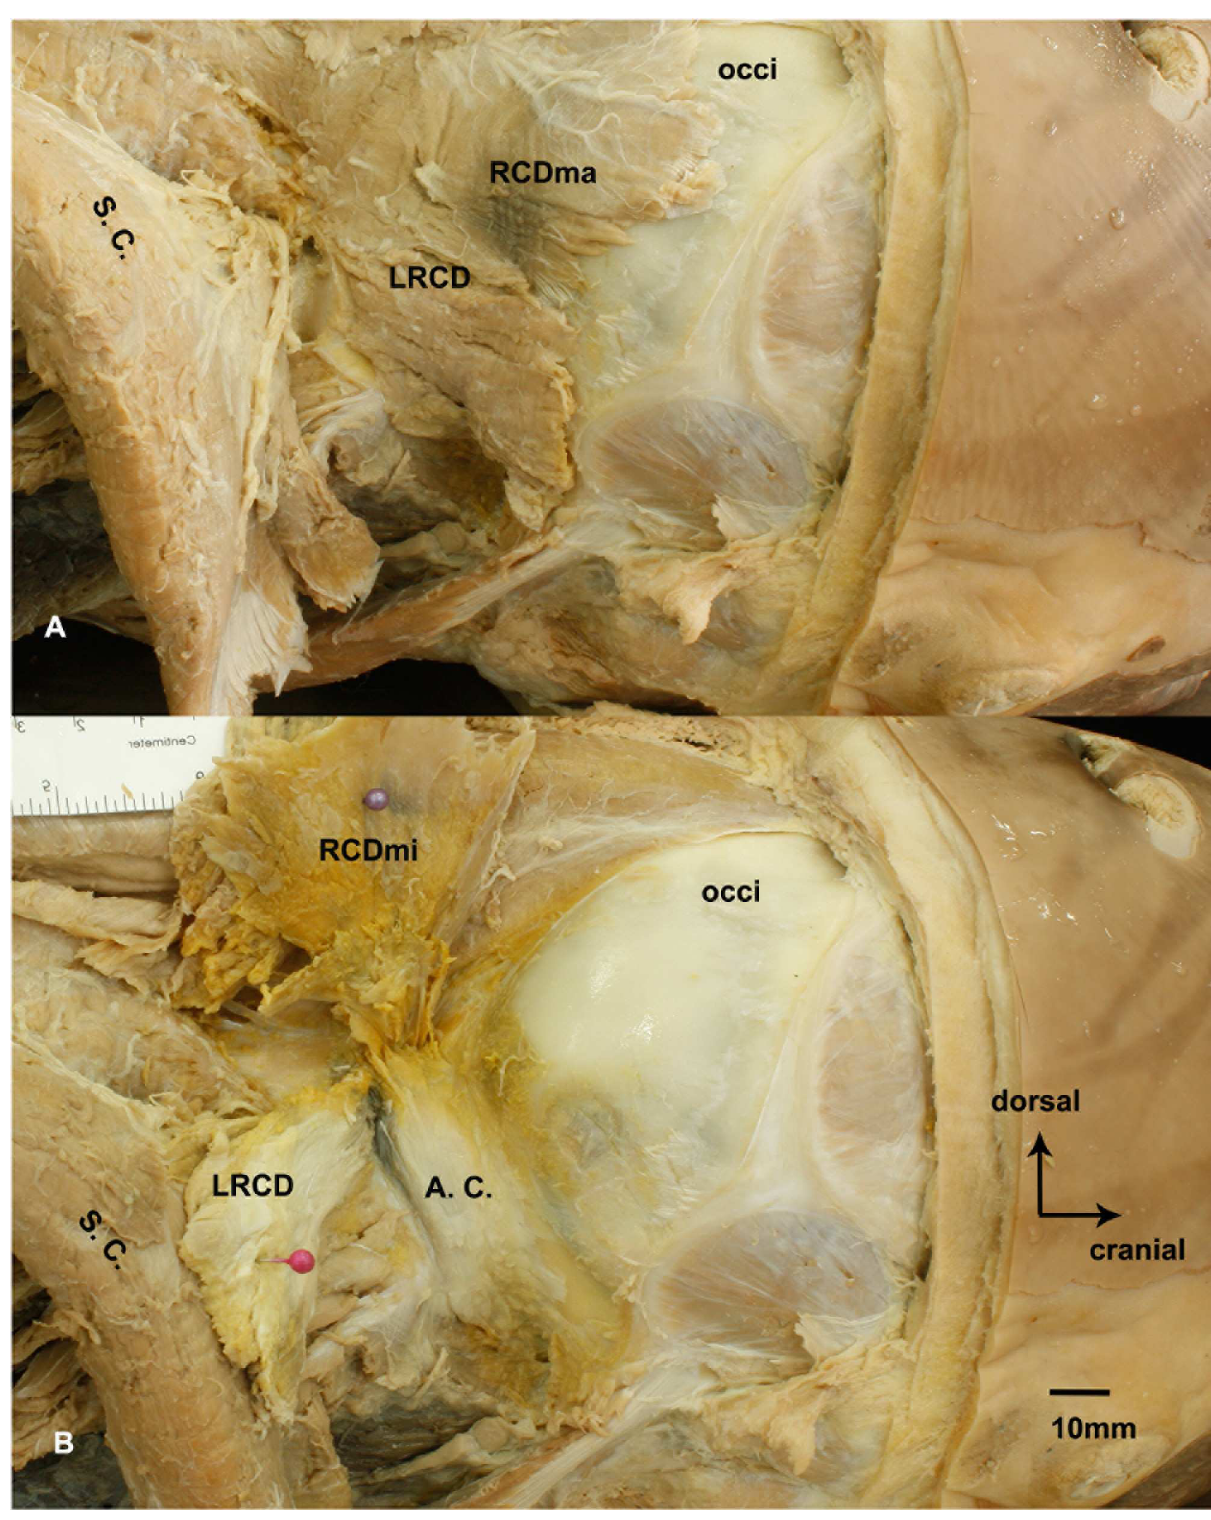
Fig 2. The suboccipital muscles of the Neophocaena phocaenoides in the atlanto-occipital interspace. A: the superficial layer of suboccipitalmusculature. B: the deep layer of suboccipitalmusculature. A. C.: articular capsuleof the atlanto-occipital joint. LRCD: the lateral rectus capitis dorsal. RCDmi: the rectus capitis dorsal minor. RCDma: the rectus capitis dorsal major. S. C.: semispinalis capitis. occi: occiput. doi:10.1371/journal.pone.0173630.g002 PLOS ONE | DOI:10.1371/journal.pone.0173630 March 9,